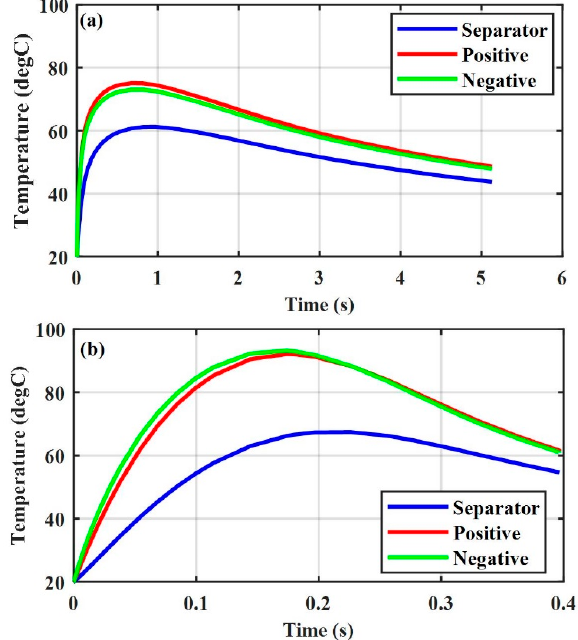
Figure 3. Thermal response of various ISC areas, SOC = 0.4, positive–negative ( a ) r in = 0.5 mm, and ( b ) r in = 1.5 mm.